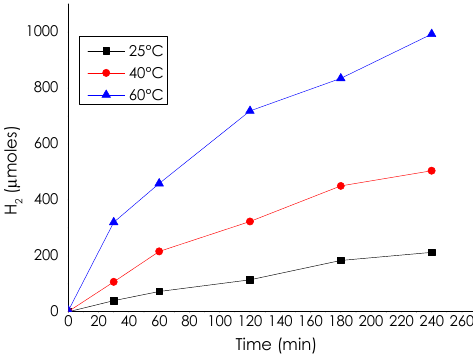
Figure 4. Temporal profile of H 2 generation from the NH 4 HCO 2 aqueous solution catalyzed by Pd-CS at 25 ◦ C, 40 ◦ C and 60 ◦ C. Reaction conditions: 10 mmoles of ammonium formate, 10 mL of milliQ water, and 11.75 µ mol of